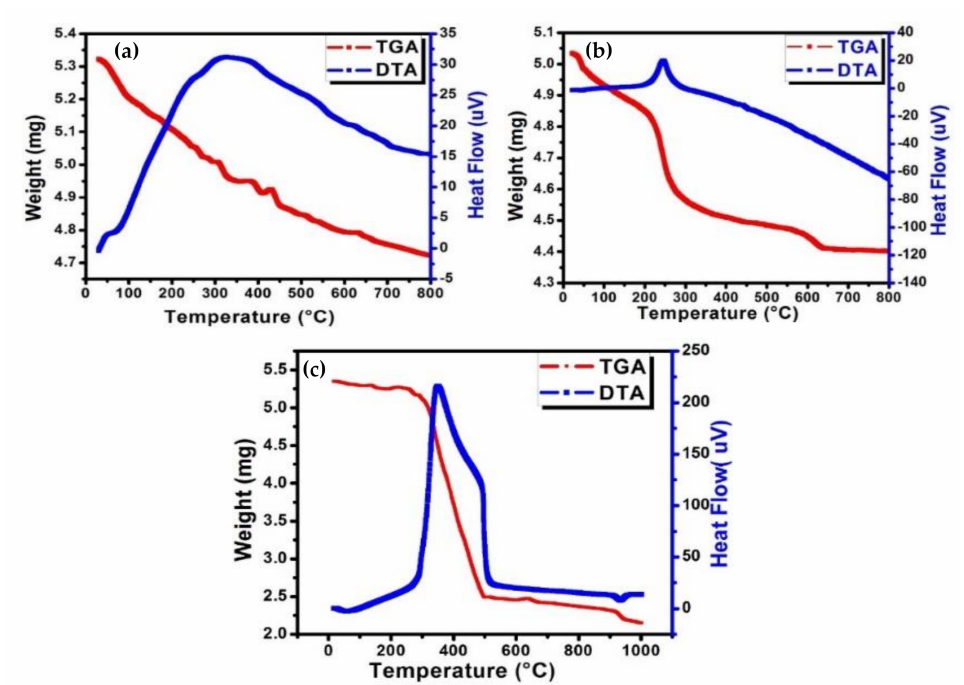
Figure 4. TG/DTA curves of ( a ) Pure CeO 2 ( b ) 10% Cu doped CeO 2 ( c ) ZIF-67/CeO 2